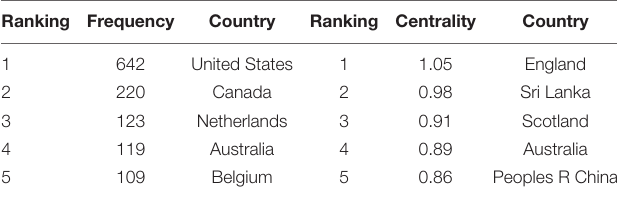
TABLE 3 | The top five countries related to pain catastrophizing. Ranking Frequency